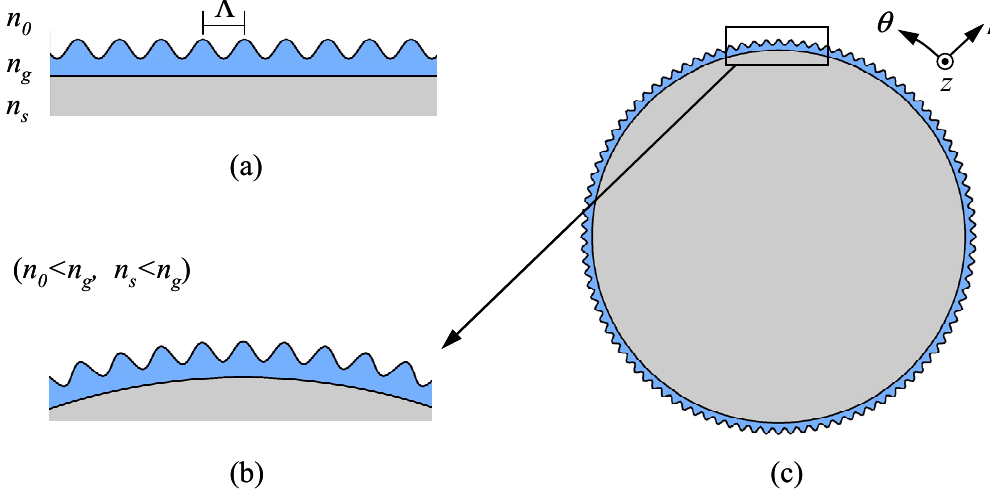
Figure 1. Schematic view of part of a flat/curved resonant grating and a circular cavity. ( a ) Conventional thin-film grating with a sinusoidal profile on a flat substrate; ( b ) Curved structure; ( c ) Cylindrical cavity with a curved grating